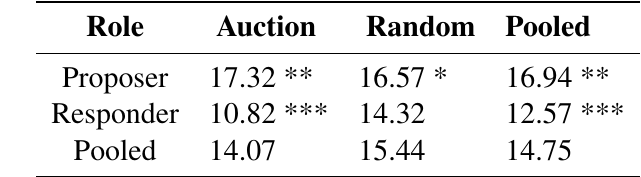
Table 1. Average final currency balances of subjects by role and treatment.